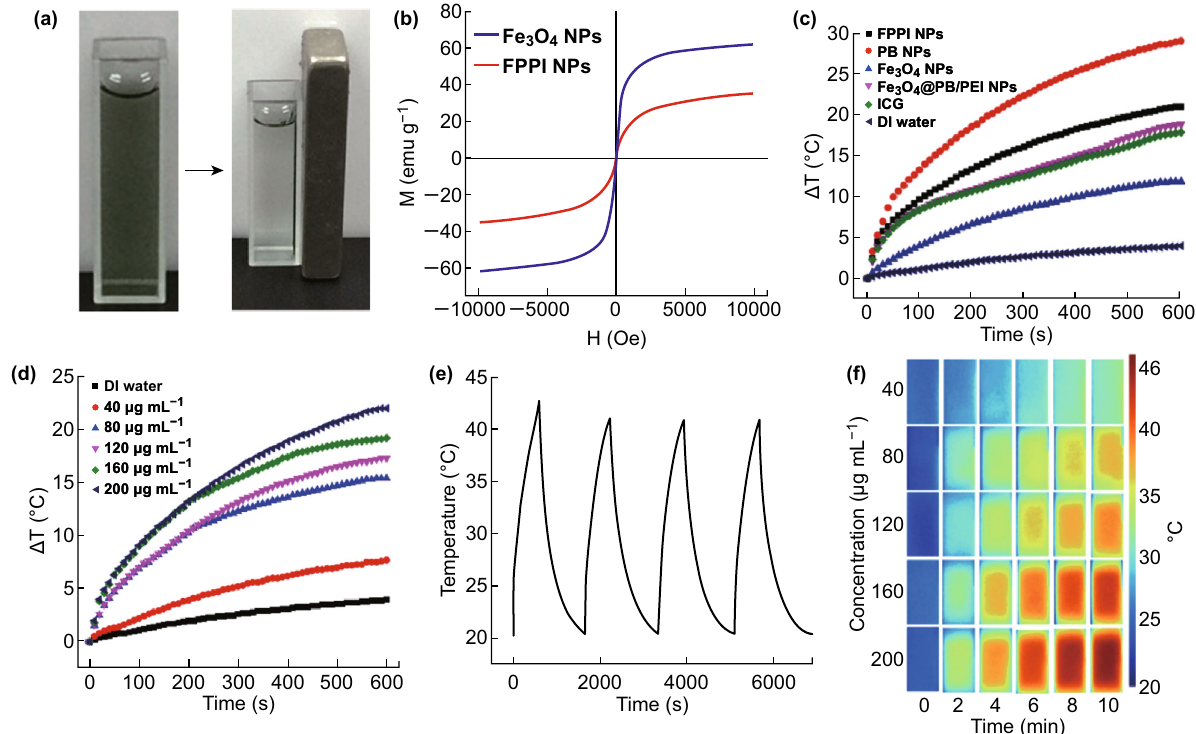
Fig. 3 Magnetic and photothermal properties of FPPI NPs: a accumulation of FPPI NPs toward a permanent magnet placed against the side wall of a cuvette containing the FPPI NP dispersion (1 mg mL - 1 ); b comparison of the magnetization response of Fe 3 O 4 and FPPI NPs at 25 (cid:3) C using a vibrating sample magnetometer; c temperature change in various solutions (200 l g mL - 1 ) over 10 min of NIR laser irradiation recorded by a digital thermometer; d temperature elevation in FPPI NP aqueous dispersions with various concentrations over 10 min of NIR laser irradiation recorded by a digital thermometer; e change in temperature of FPPI NP dispersion under repeated laser irradiation over four consecutive heating– cooling cycles (10 min of irradiation for each cycle); f infrared thermal images of cuvettes containing the FPPI NP dispersion to show the temperature change over time under different NP concentrations (NIR laser wavelength: 808 nm; laser power: 2 W cm - 2